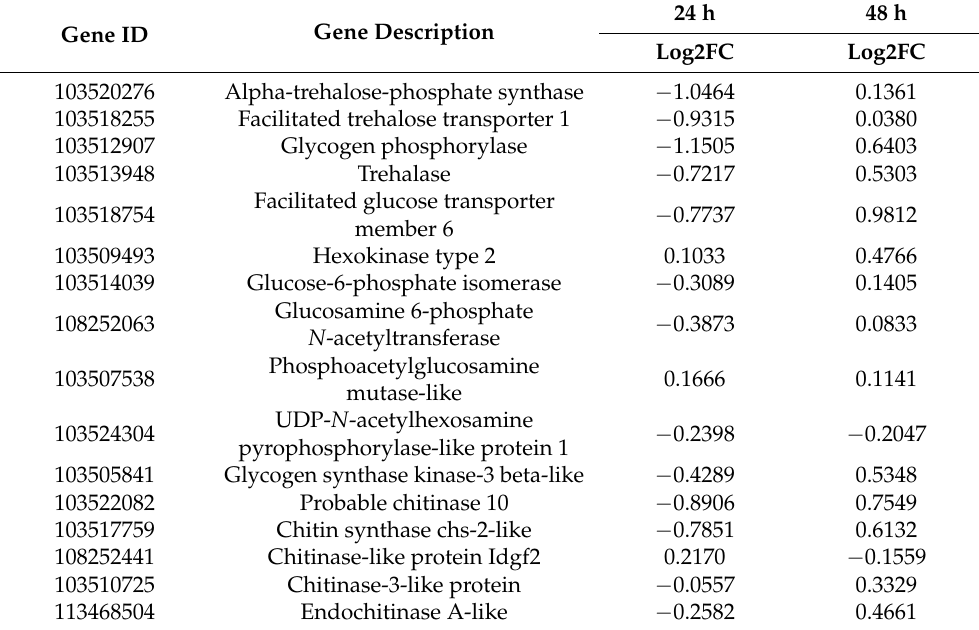
Table 1. Identification of DEGs associated with chitin metabolism in different comparable groups.